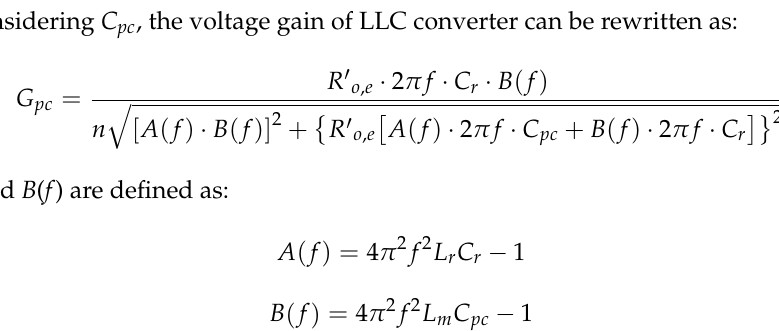
Figure 3. Equivalent model of LLC resonant converter considering parasitic parameters.